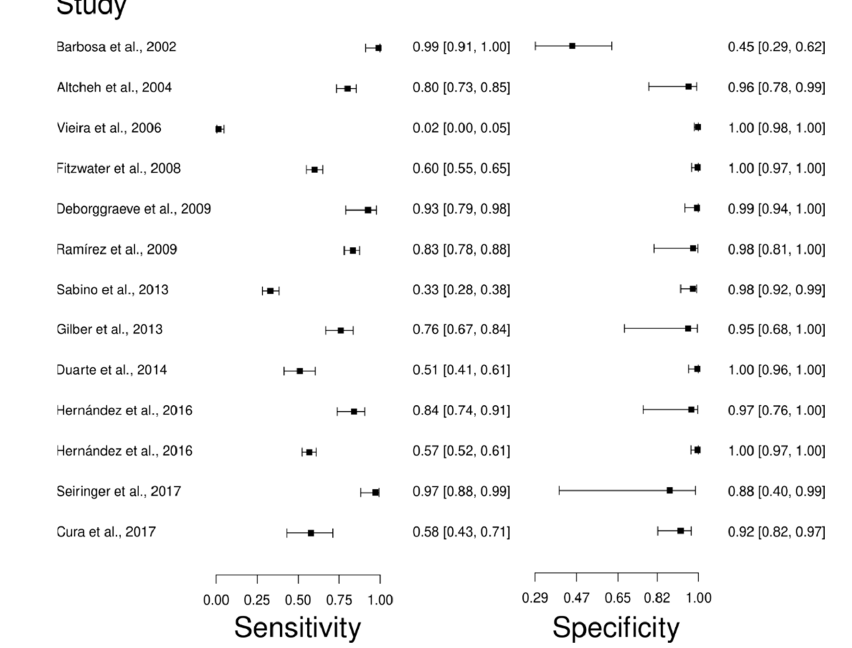
Figure 7. Study data and paired forest plot of the sensitivity and specificity Polymerase chain reaction (PCR) in Chagas’s disease diagnosis. Data from each study are summarized. Sensitivity and specificity are reported with a mean (95% confidence limits). The Forest plot depicts the estimated sensitivity and specificity (black circles) and its 95% confidence limits (horizontal black line) [66,67,76,88–97].